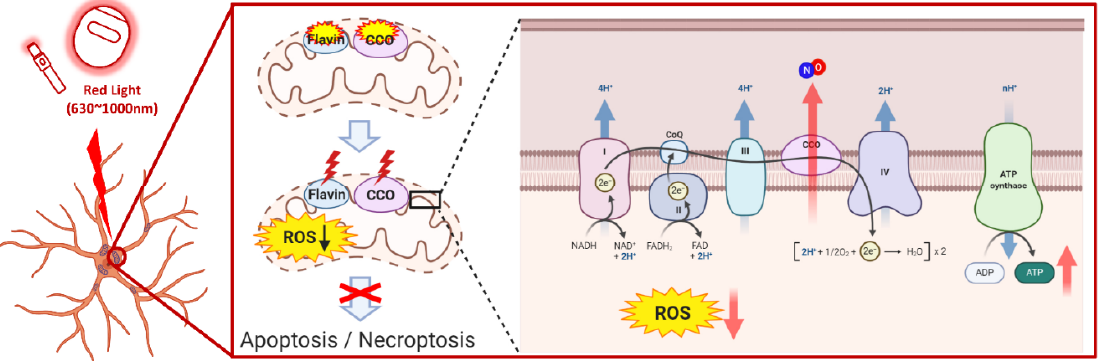
Figure 3. Illustration showing the proposed mechanism by which red light may have a beneficial effect on glaucoma. This figure was created using PowerPoint & BioRender (Available online: http://biorender.com (accessed on 9 April